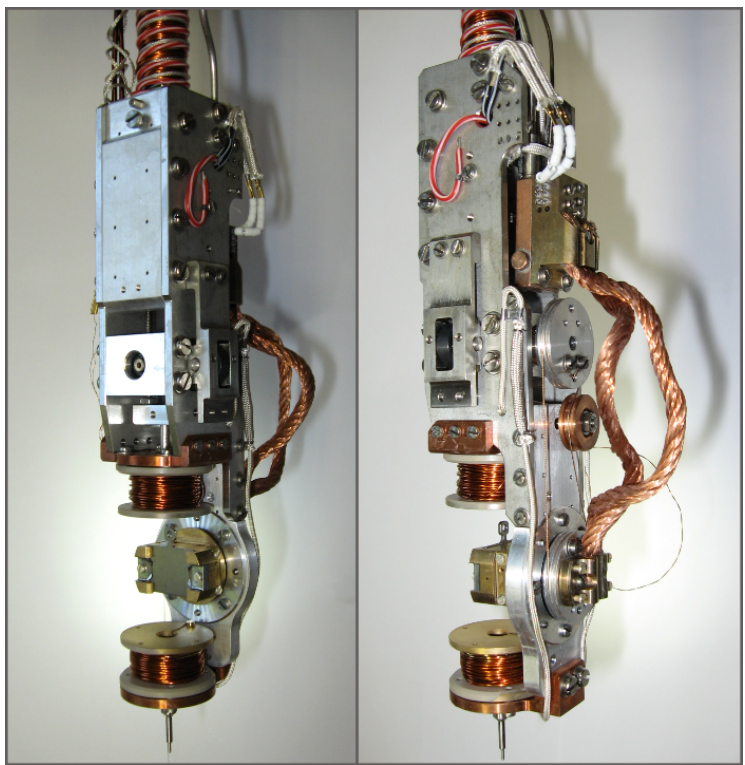
Figure 3: 5-axes manipulator “Pente.Ax” with integrated Helmholtz coils (designed by A.